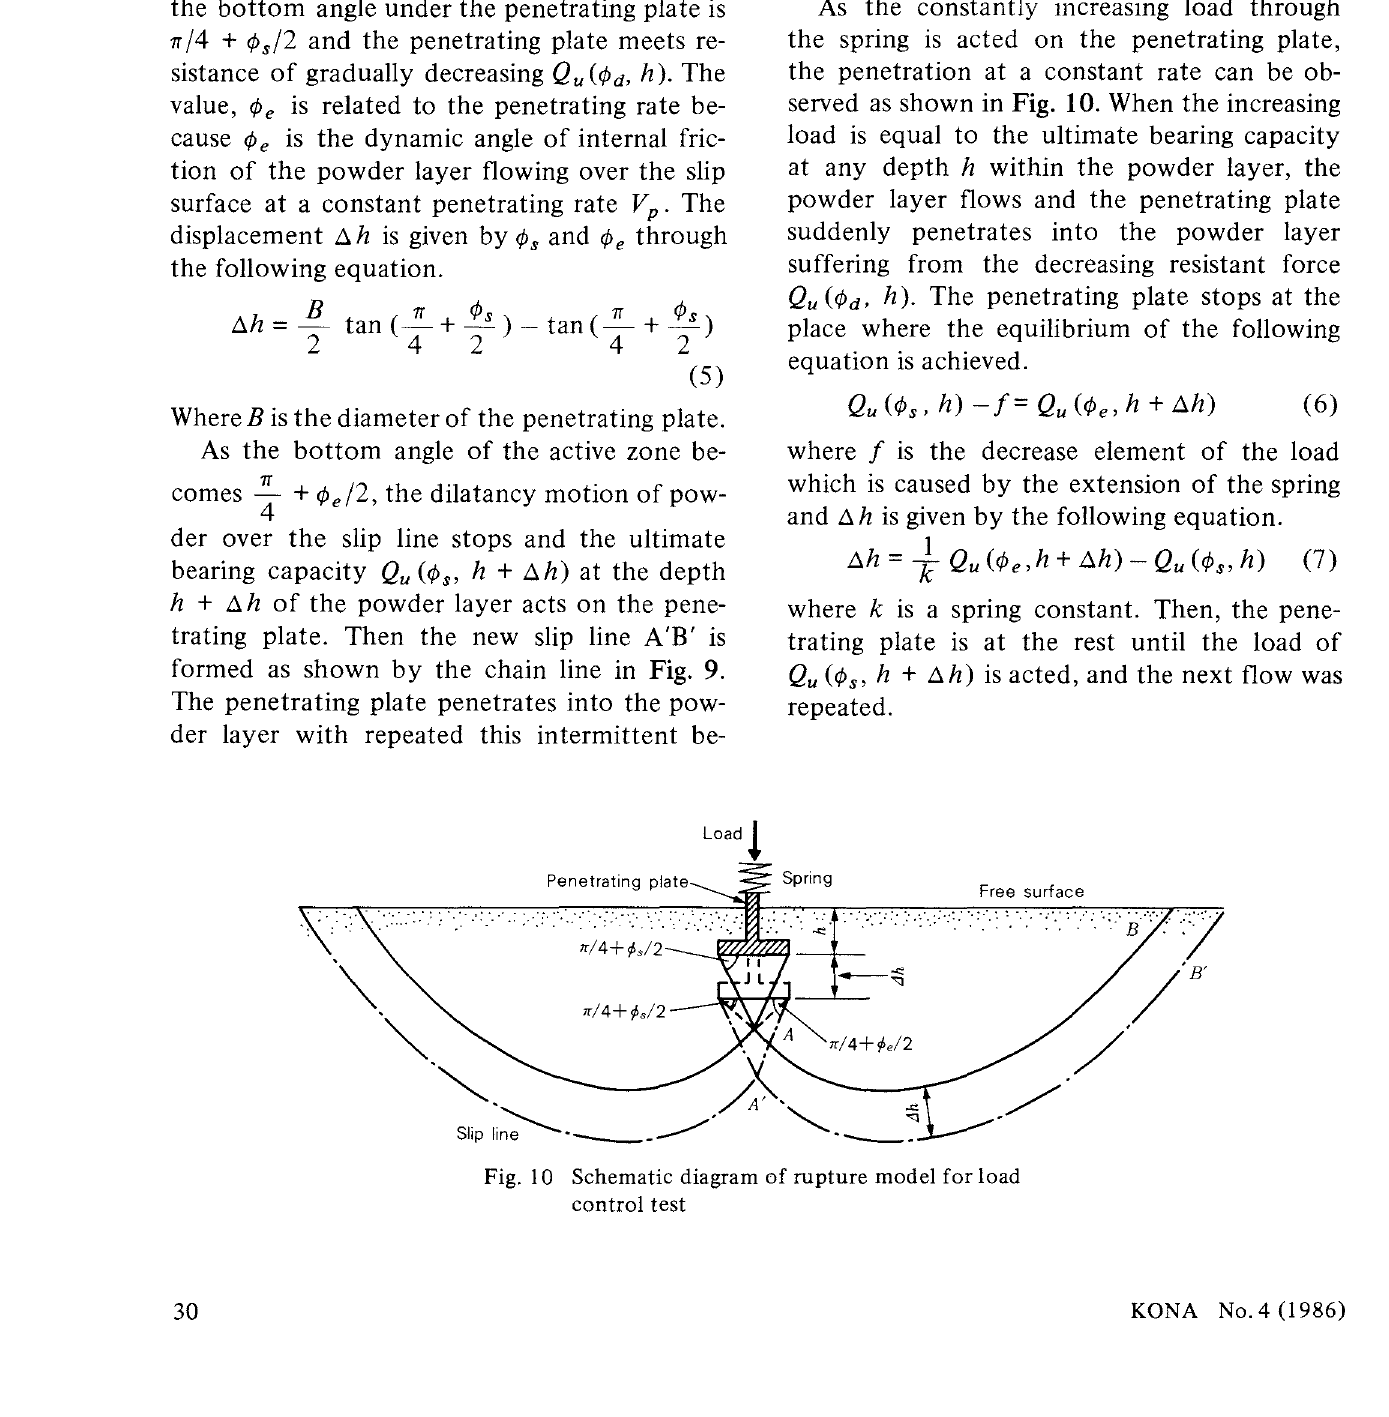
Fig. 9 Schematic diagram of rupture model for displacement control test